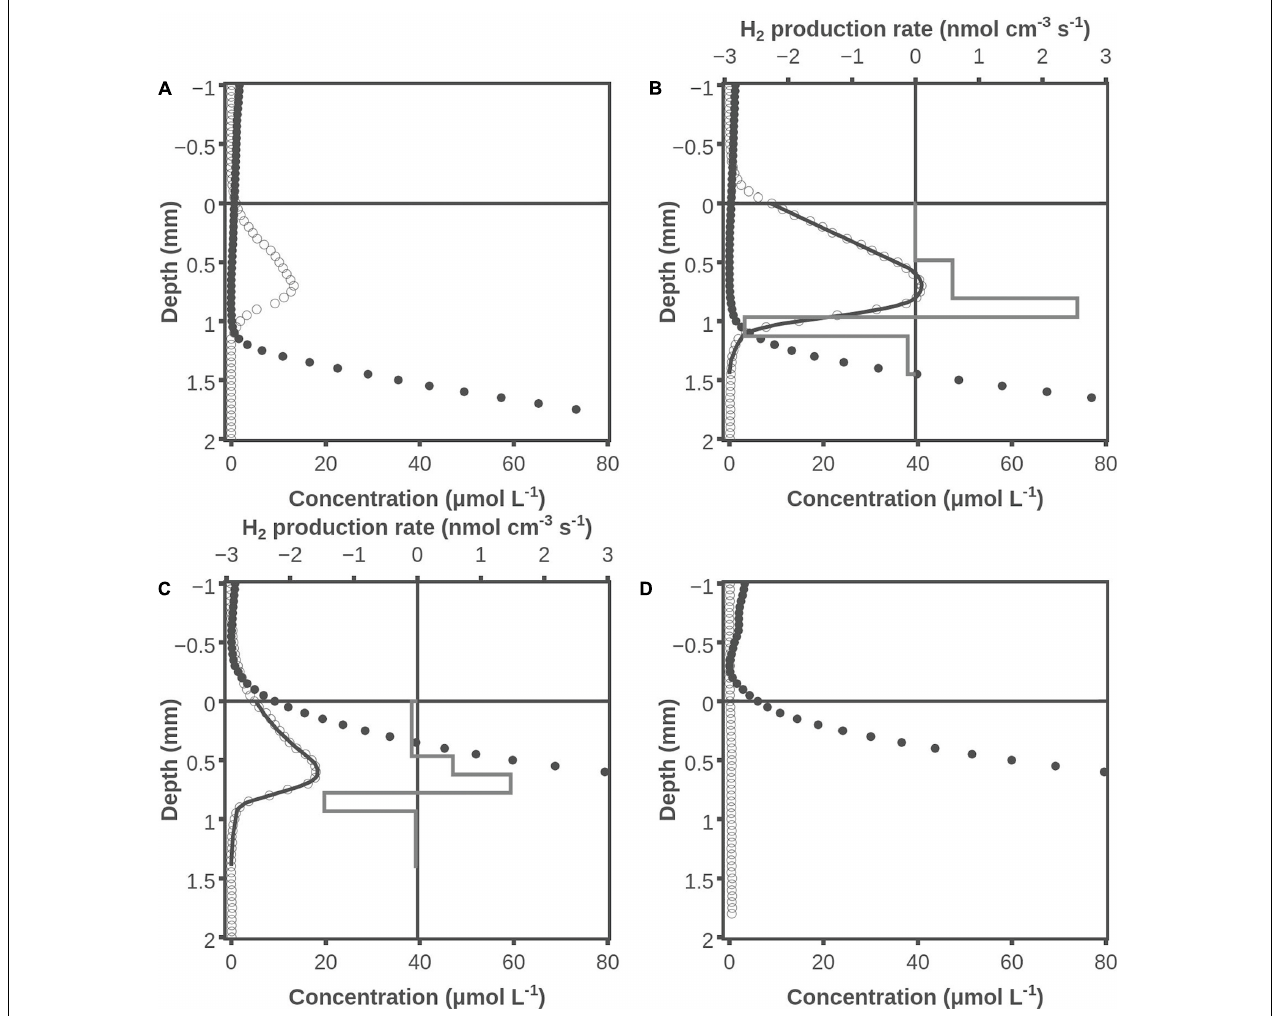
FIGURE 2 | Examples of hydrogen and hydrogen sulfide concentration profiles under dark conditions. One minute after darkening (A) , 20 min after darkening (B) , 120 min after darkening (C) , and 240 min after darkening (D) . Shown are measured H 2 concentrations ( profile ( –––– ), and modeled H 2 production rate (box diagram). Data obtained by use of the combined H 2 - H 2 S